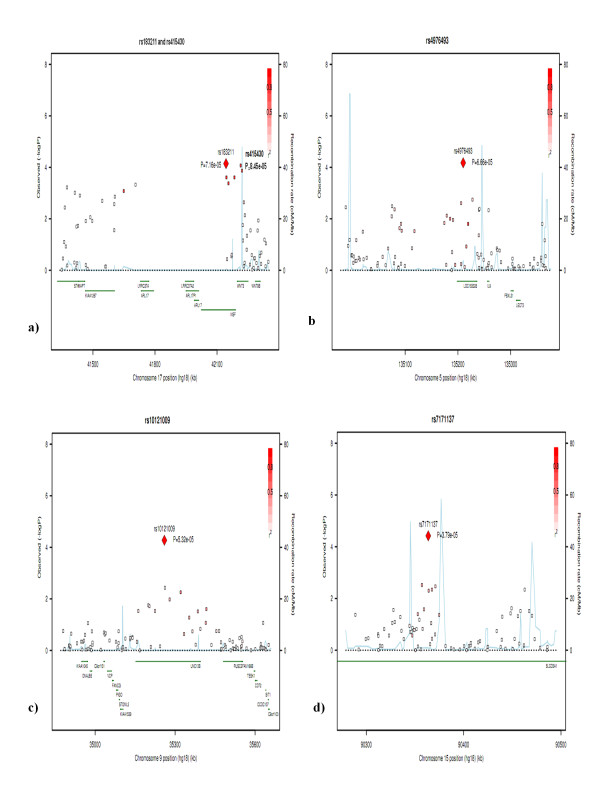
Regional Association Plots for SNPs significant in the association analysis in the Ashkenazi Jewish dataset a) NSF and WNT3, b) LOC153228/SLC25A48, c) UNC13B, d) SLCO3A1. It shows -log10 (p-value) from association analysis for all SNPs in the region around the top SNP (surrounding 1000 kb total). X-axis shows position of the SNPs along chromosome; Y-axis gives -log10(p-value). P-values were obtained from GWAS in each dataset. Y-axis in the right shows recombination rate (cM/Mb). r2 shows measure of the LD between this SNP and target SNP.